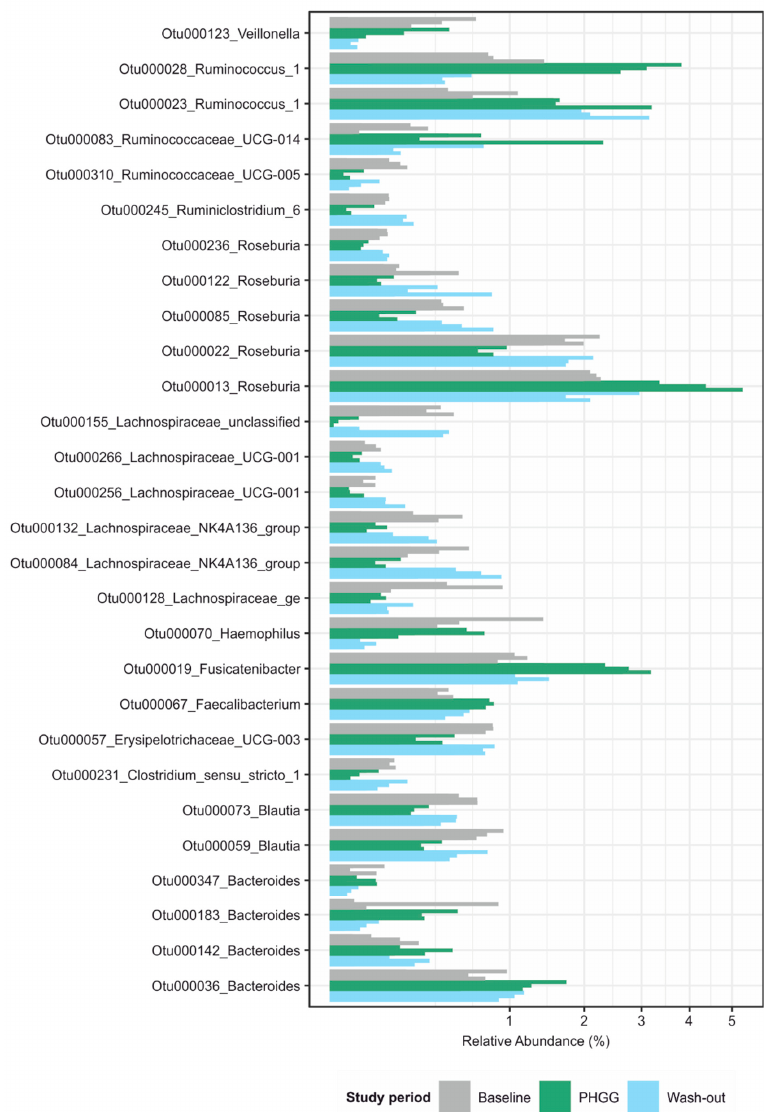
Figure 3. Significantly differentially abundant OTUs and their mapping on the genus level in the V3– V4 dataset. Testing was carried out using a negative binomial model implemented in DESeq2 and a cutoff of 0.01 for the adjusted p -value. OTU = operational taxonomic unit; UCG = unknown classification group; PHGG = partially hydrolyzed guar gum.